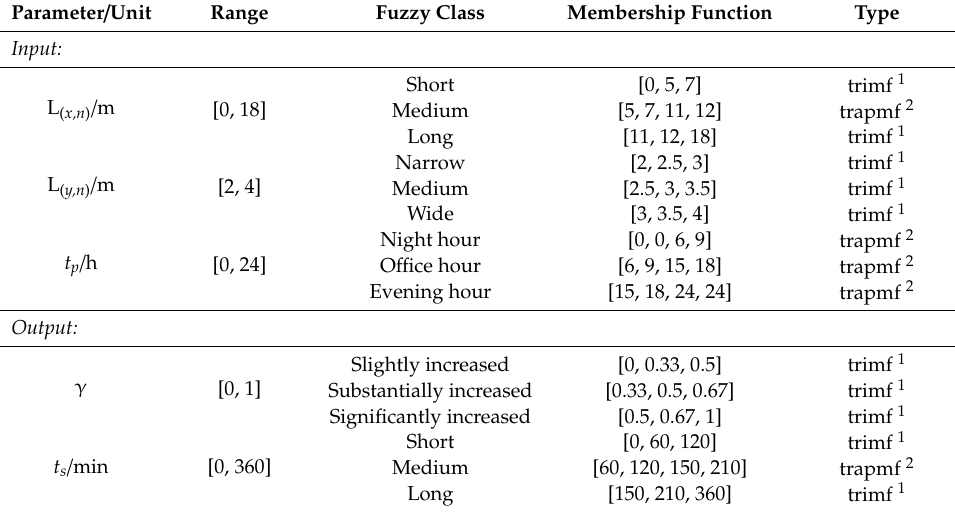
Table 1. Definitions of fuzzy classes and membership functions in the